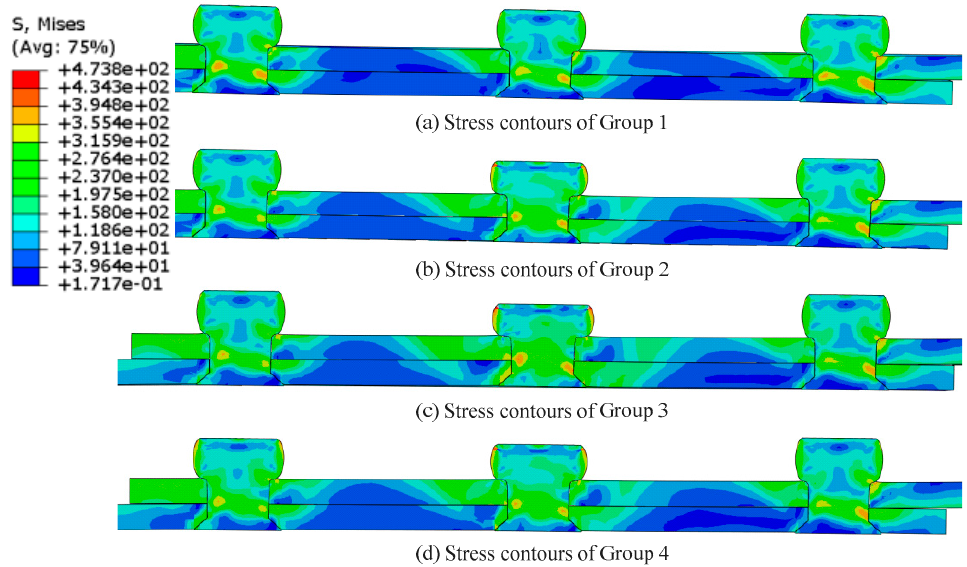
Figure 8. Stress contours of the riveted lap joints (Unit: MPa). ( a ) Stress contours of Group 1. ( b ) Stress contours of Group 2. ( c ) Stress contours of Group 3. ( d ) Stress contours of Group 4.